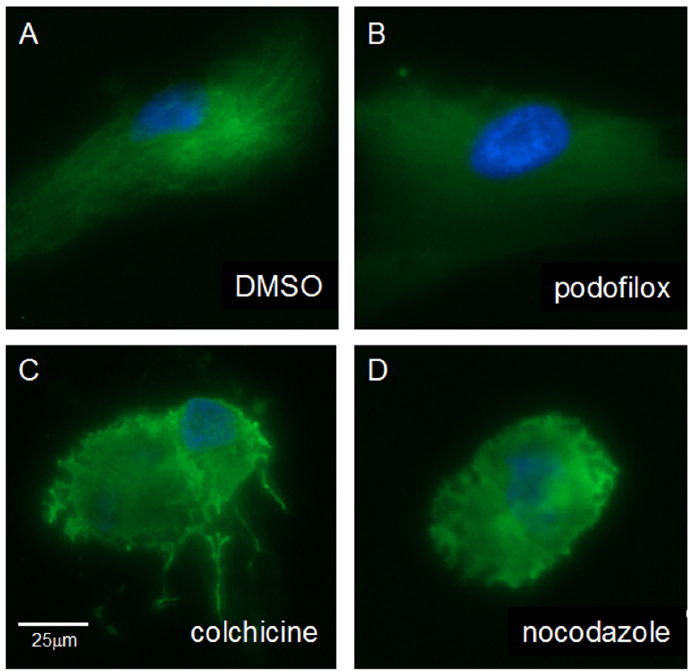
Figure 8. Fluorescent microscopy of MRC5 cells treated with microtubule inhibitors for 1 h. MRC5 cells were treated for 1 h with DMSO ( A ); 50 nM podofilox ( B ); 500 nM colchicine ( C ); or 5 µ M nocodazole ( D ). Cells were stained with murine anti-tubulin antibody and visualized anti-mouse antibody conjugated to Alexa 488 (green) and nuclei stained with Hoescht reagent (blue). Scale bar is 25 µ